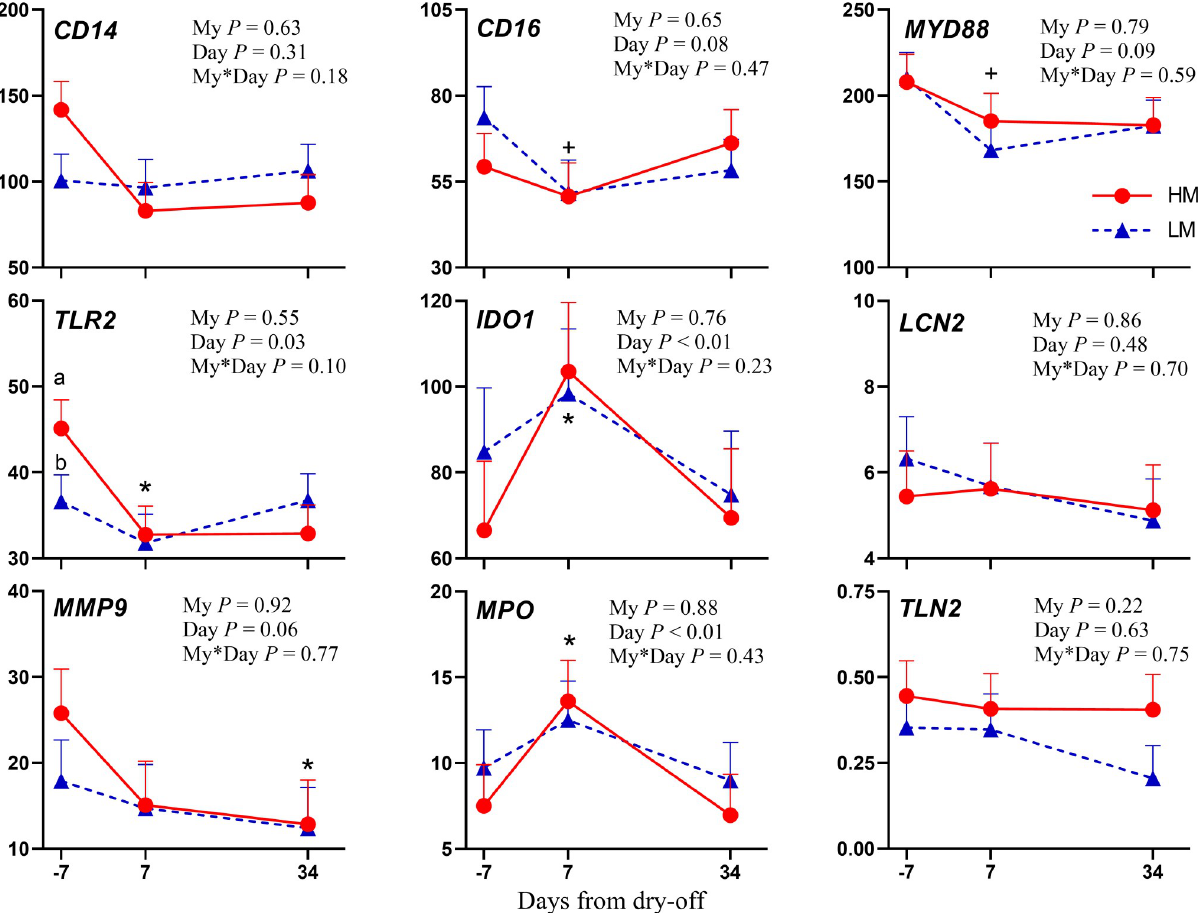
Fig 3. mRNA abundance of genes involved in recognition and immune mediation and antimicrobial strategies. Changes from -7 days from dry-off (DFD) to 34 DFD in dairy cows with high (HM; red line) or low (LM; blue line) milk yield at dry-off in mRNA abundance (mean ± SEM) for gene expression of genes involved in recognition and immune mediation and antimicrobial strategies: CD14 (Cluster of Differentiation 14), CD16 (Cluster of Differentiation 16 or Fc Fragment of Igg Receptor IIIa), MYD88 (Myeloid Differentiation Primary Response Gene 88), TLR2 (Toll-Like Receptor 2), IDO1 (Indoleamine 2,3-Dioxygenase 1), LCN2 (Lipocalin 2), MMP9 (Matrix Metallopeptidase 9), MPO (Myeloperoxidase), TLN2 (Talin 2). P -values for main effect of milk yield at dry-off (My), day, and interaction of milk yield × day (My � Day) are shown. Significant differences ( P � 0.05) between groups on the same day are denoted with lowercase a and b, and differences between -7 DFD and 7 or 34 DFD are denoted with an asterisk ( � ; P � 0.05) or a plus sign (+; P � 0.1).